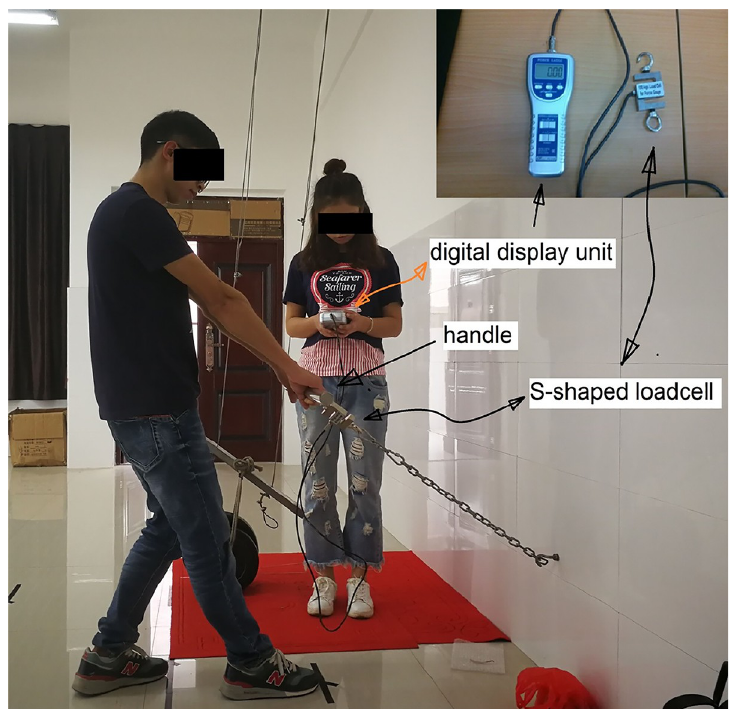
Fig 2. Pulling strength testing. Note: The individual in this photo has given written informed consent (as outlined in PLOS consent form) to publish these case details.